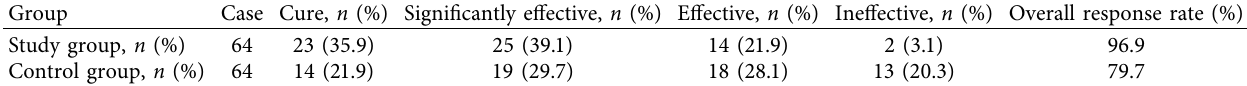
Table 2: Comparison of clinical efficacy between the two groups.